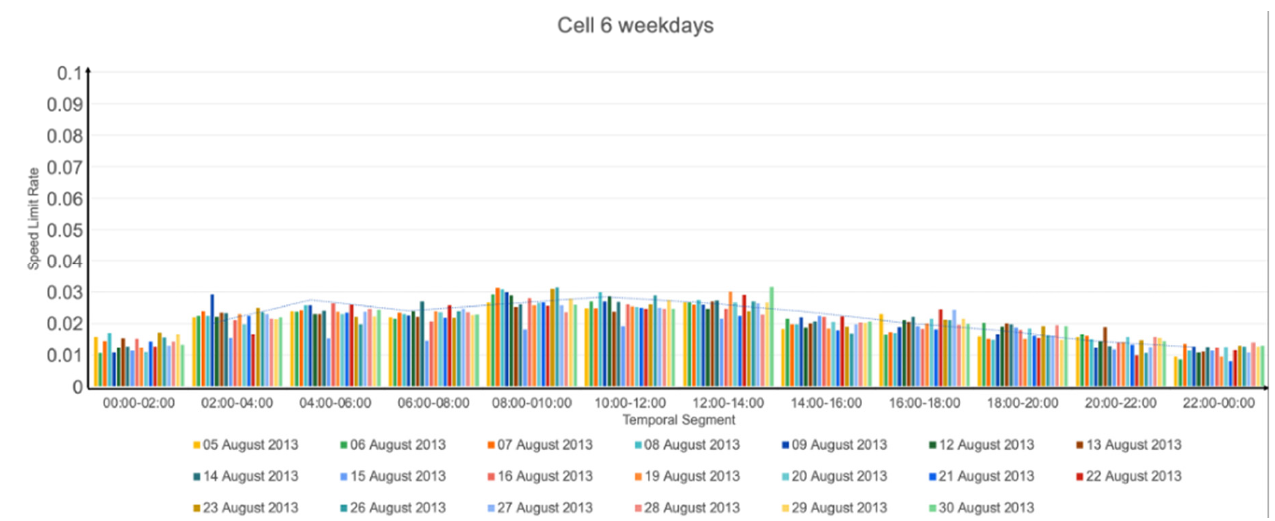
FA8 Figure A8. Results for the weekdays, cell 6 with MaxSpeed = 10